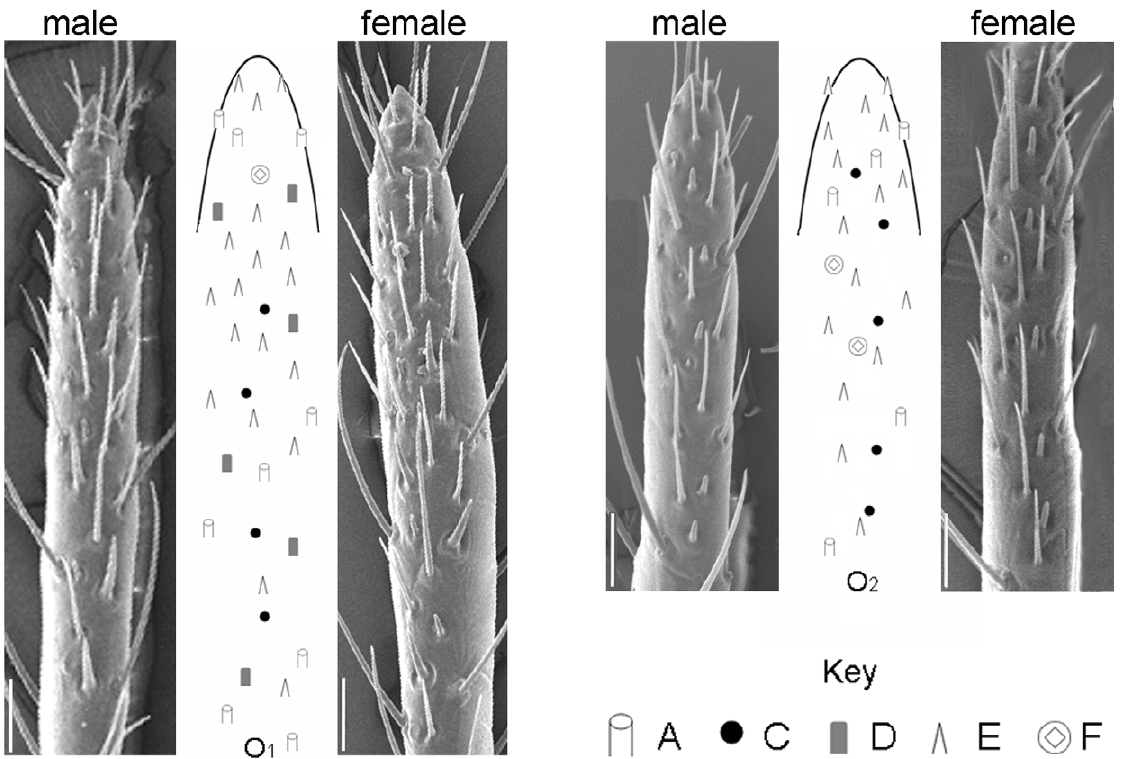
Figure 1. Sensilla distribution on terminal antennal segment of C.hemipterus . Schematic maps of sensillum distribution on the inner (O 1 ) and outer (O 2 ) surfaces of the terminal antennal segment of C. hemipterus , flanked by Scanning Electron Microscopy (SEM) photographs of the corresponding regions in males and females to demonstrate a lack of sexual dimorphism. The map was derived from analysis of SEM images of 12 male and 9 female antennae. The position and relative distances between individual sensilla are roughly to scale, leaving room for minute individual variation and scale bars represent 20 m m. For C. lectularius comparison, see Steinbrecht and Mu¨ller [20].